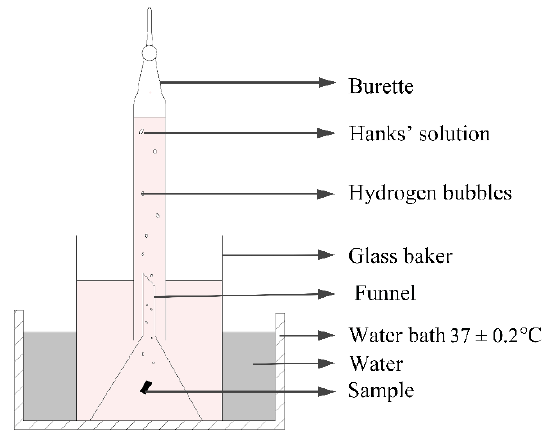
Figure 2. Schematic diagram of hydrogen evolution